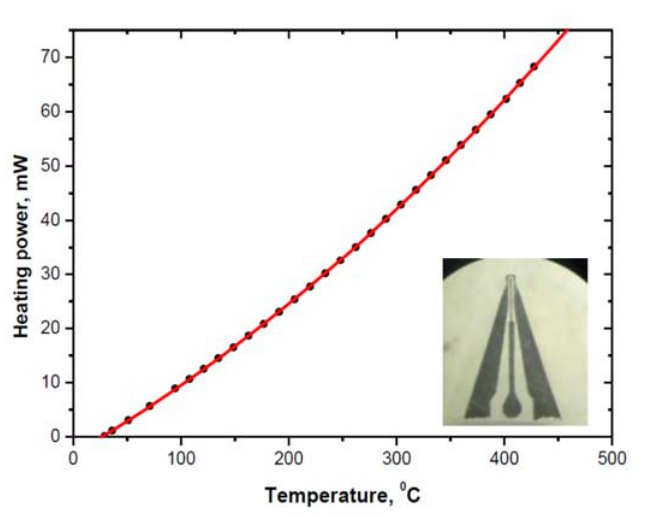
Figure 3. Power consumption of microheater on 12 μ m alumina ceramic film as a function of microhotplate temperature. The microheater view is given on close-up photo.